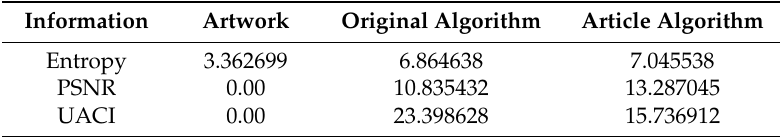
Table 2. Analysis of Test Results.